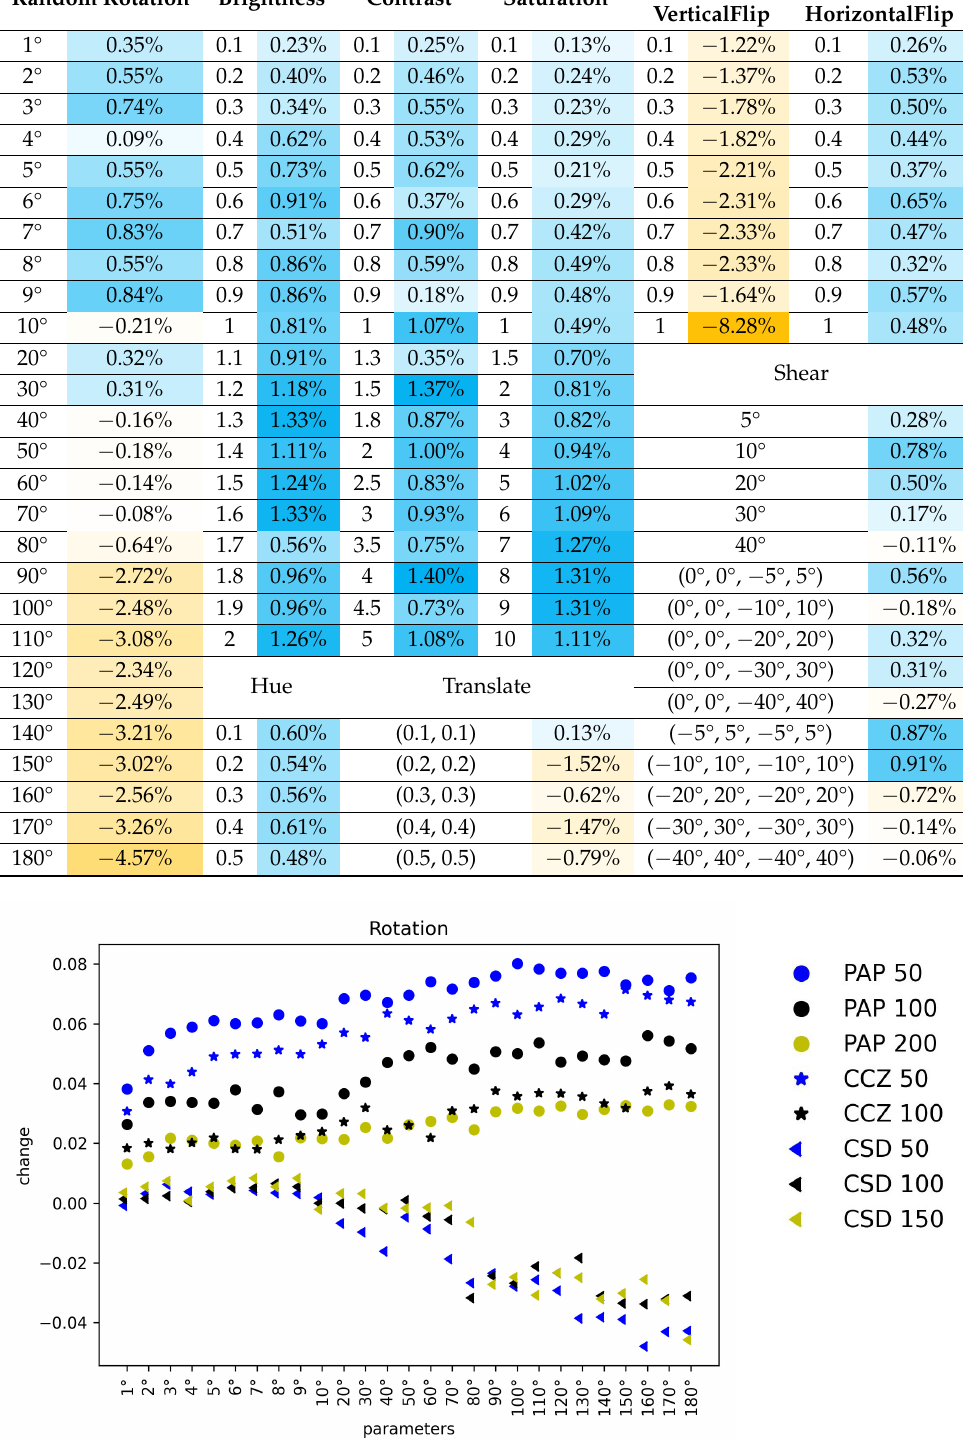
Random Rotation Contrast